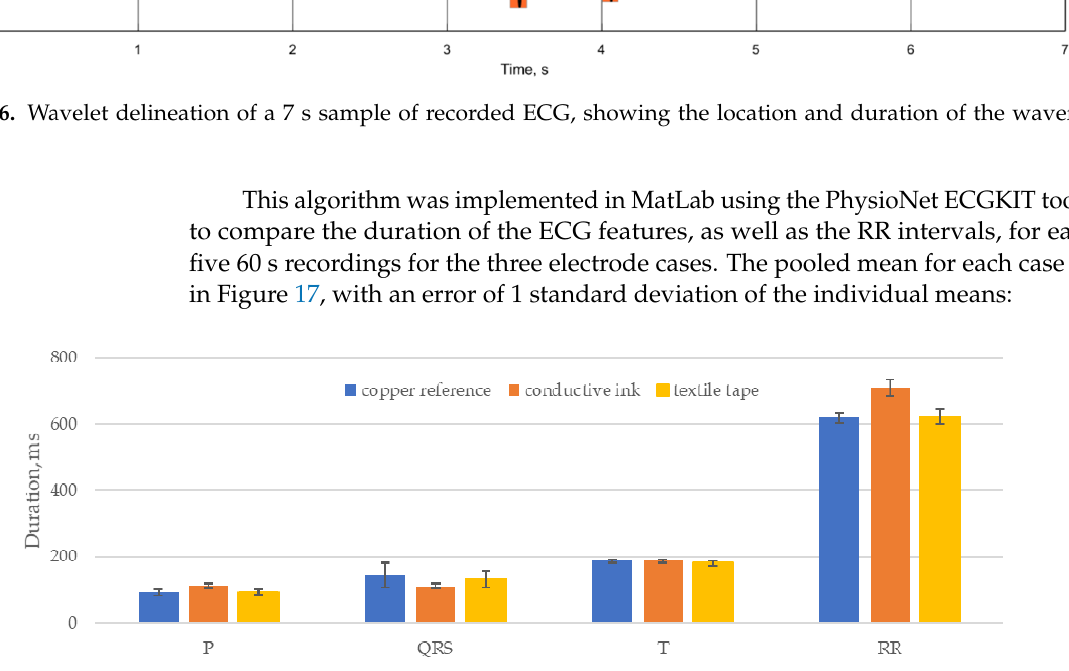
Figure 17. mean P QRS and T lengths and RR intervals for each electrode case.